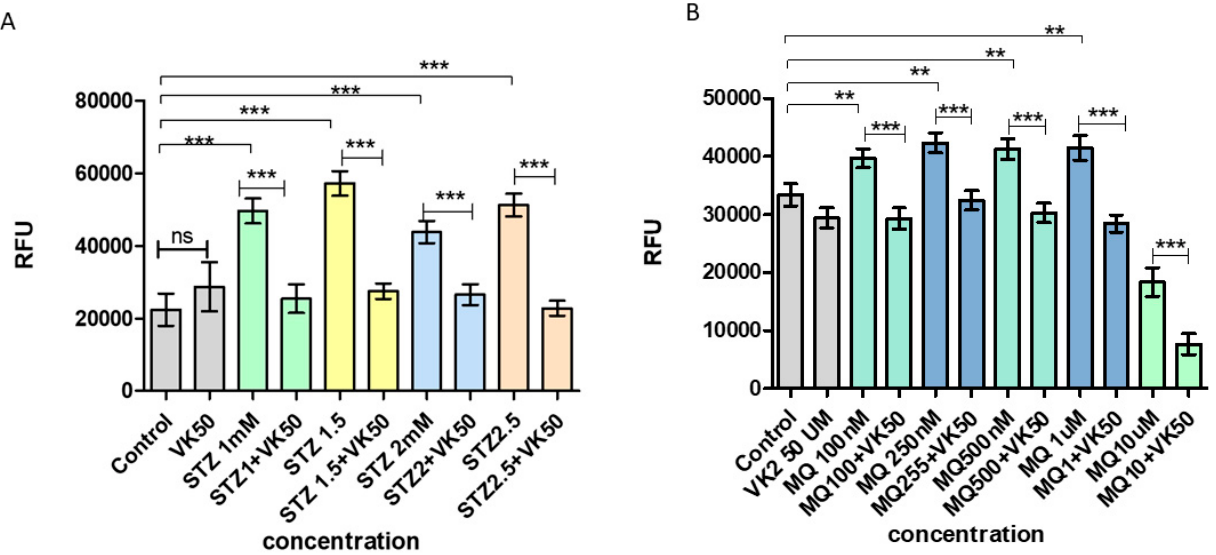
Figure 3. Measurement of reactive oxygen species production in human SH-SY5Y neuroblastoma cells after ( A ) strepto- zotocin treatment and post-treatment with vitamin K2 (50 µM) and ( B ) menadione treatment (MQ) and post-treatment with vitamin K2. The Y -axis represents the relative fluorescence unit (RFU) and the X -axis represents the concentrations of streptozotocin and menadione. The data are presented as mean ± SEM. Statistical analysis was performed using Student’s t -test and differences with p -values ≤ 0.05 were designated as significant. * p < 0.05, ** p < 0.01, and *** p < 0.001 denote significant differences compared to the control and between the treatment groups. (STZ—streptozotocin; VK2—vitamin K2; SV—post-treatment of streptozotocin (1–2.5 mM)-treated cells with vitamin K2 (50 µM); MQ-menadione; MQ + VK2—post-treatment of menadione (100 nM–10 µM)-treated cells with vitamin K2 (50 µM).).